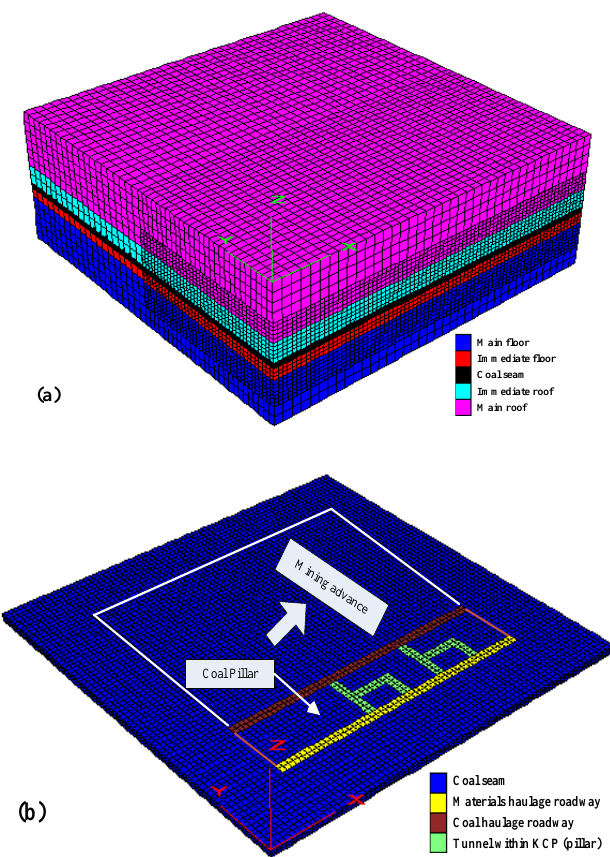
Figure 10. Sketch of the fast Lagrangian analysis of continua in three dimensions (FLAC 3D ) mesh for the coal panel. ( a ) Main model; ( b ) Coal seam design.